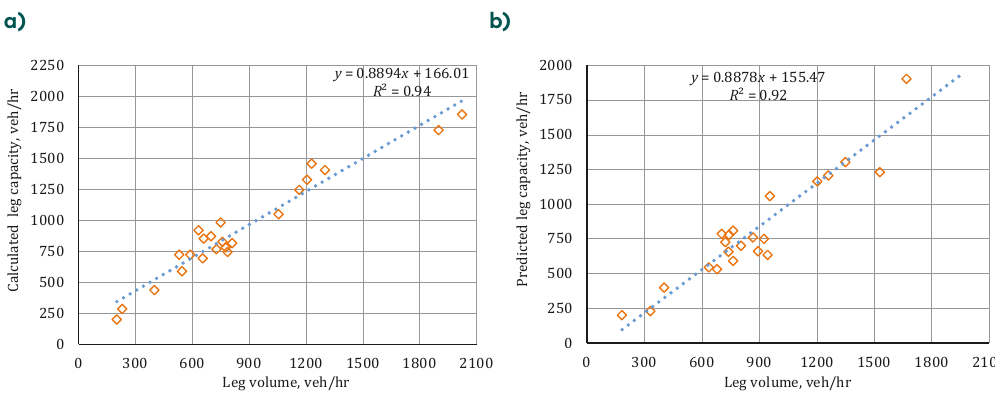
y x R = 0.8894 + 166.01 ² =